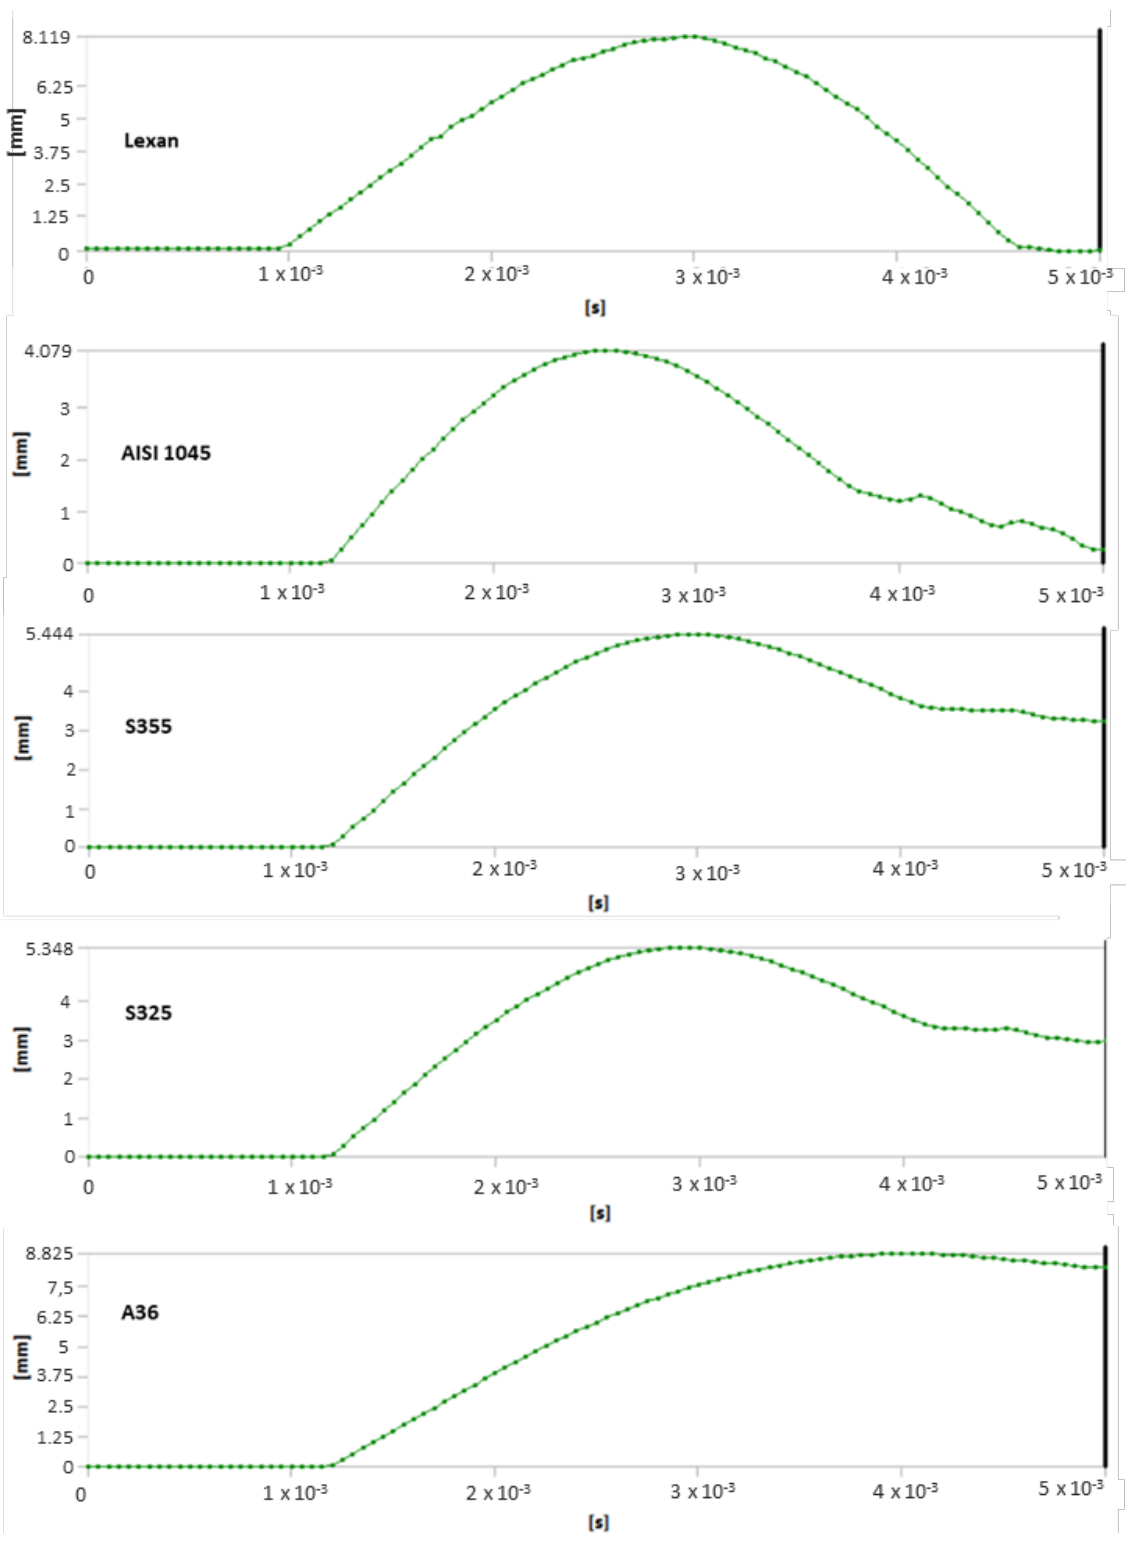
Figure 9. Deformation-over-time diagrams for the studied models.